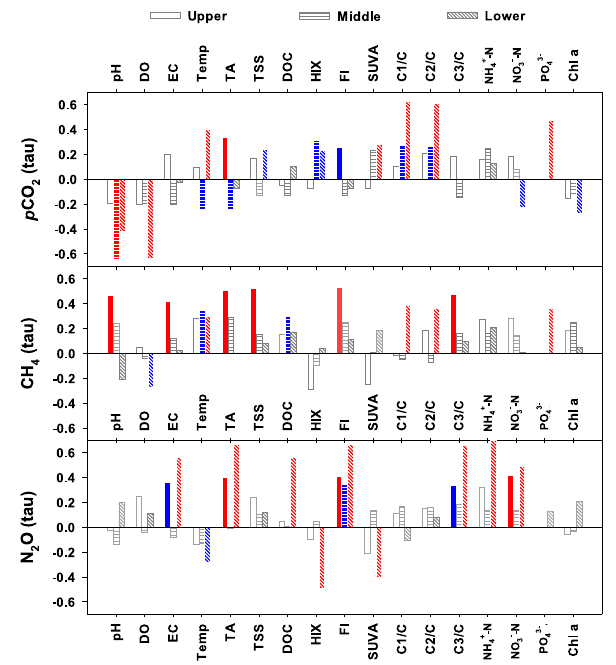
Figure 5. Kendall rank correlations (tau) between GHGs and wa- ter quality components measured in the upper, middle and lower reaches of the Han River. Significant correlations at P < 0 . 05 and P < 0 . 01 are indicated by blue and red, respectively. Please note that correlation analysis results were not available for PO 3 − upper and middle reaches due to many values below detection